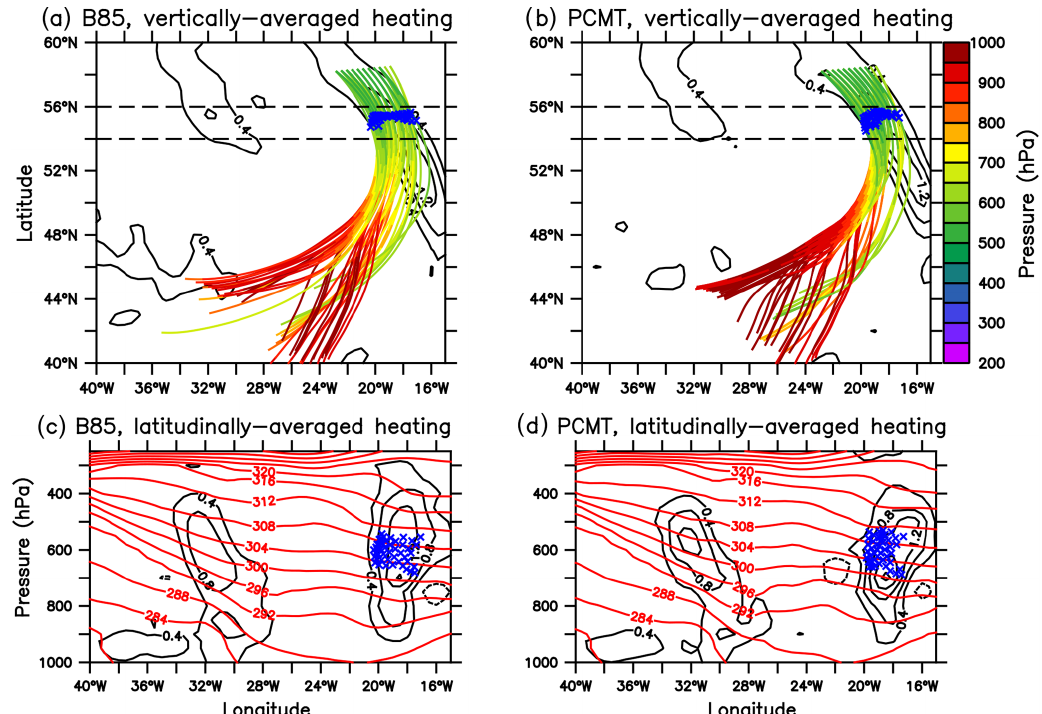
Figure 9. Same as Fig. 7 but for the trajectories reaching the negative PV difference in leg 2 shown in Fig. 5a, b and at 12:00UTC 2 October.